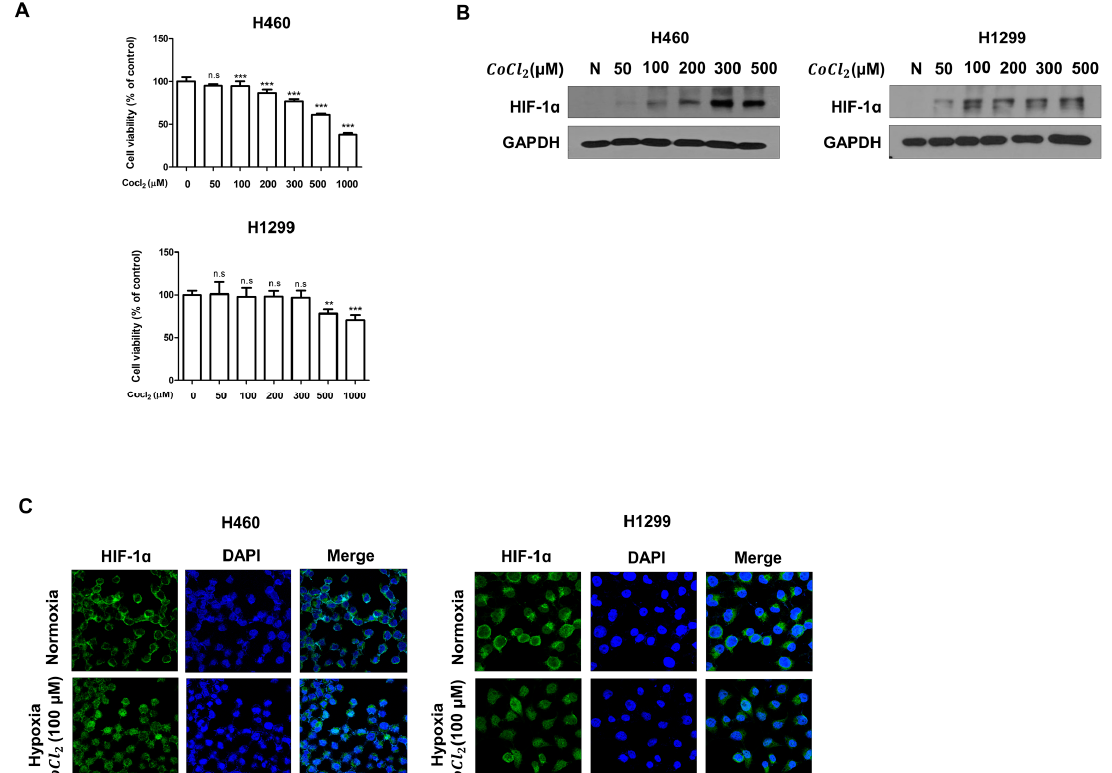
Figure 5. Cobalt chloride ( 𝐶𝑜𝐶𝑙 (cid:2870) ), a chemical agent, induces HIF-1 α . H460 and H1299 cells were treated with 𝐶𝑜𝐶𝑙 (cid:2870) for 24 h. ( A ) H460 and H1299 cells were treated with different concentrations of CoCl (cid:2870) for 24 h. Cell viability was measured by the MTT assay. ( B ) Whole-cell lysates were analyzed by Western blotting with anti-HIF-1 α and anti-GAPDH antibodies. ( C ) Confocal images demonstrating the subcellular localization of HIF-1 α (green) in cells treated with CoCl (cid:2870) are shown. Nuclei were stained with DAPI (blue). The data are presented as the mean ± SEM, n.s no significance, ** p < 0.01, and *** p < 0.001 compared to untreated cells.